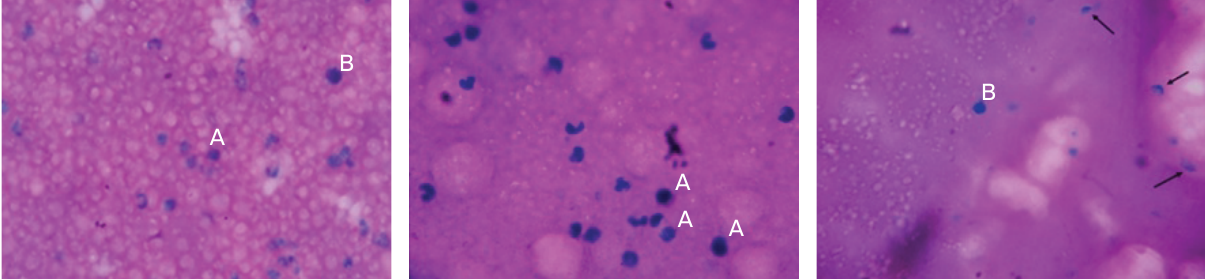
Figure 2. Smear of ovine milk for somatic cell counting prepared with Carnoy’s solution and Broadhust‑Paley staining, evidencing: (A) mononuclear cells; (B) polymorphonuclear; (arrows) corpuscles of inclusion (magnification 100